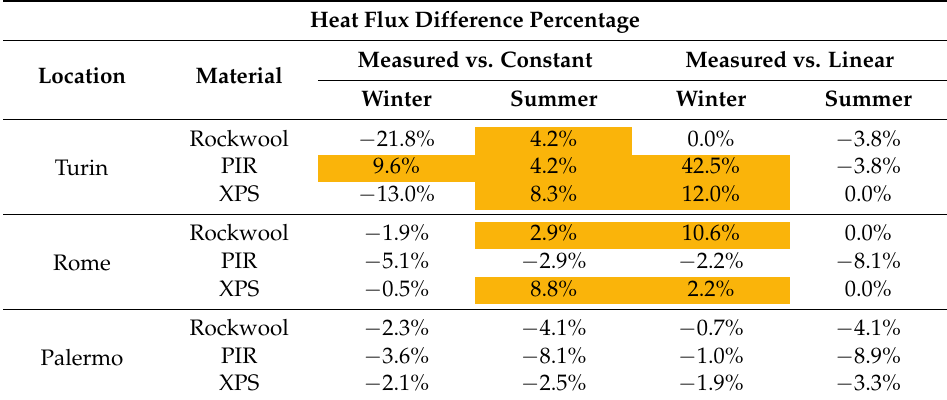
Table 4. Percentage difference of heat flux for flat